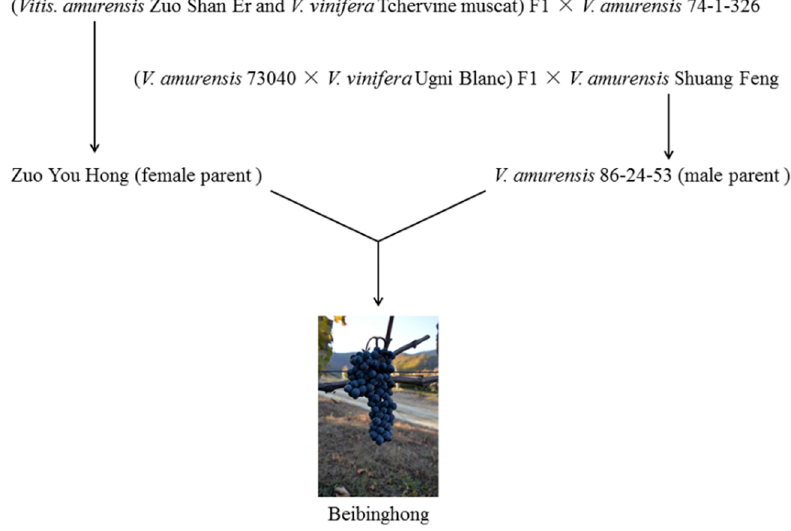
Figure 1. The family tree of hybrid cultivar Beibinghong.